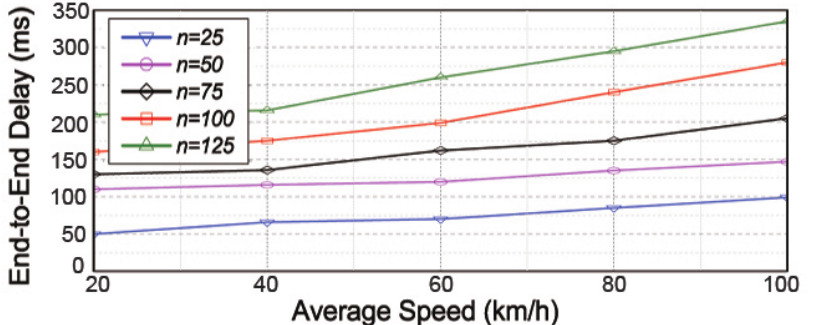
Figure 6. End-to-end delay (ms) vs. beacon transmission frequency (Hz).